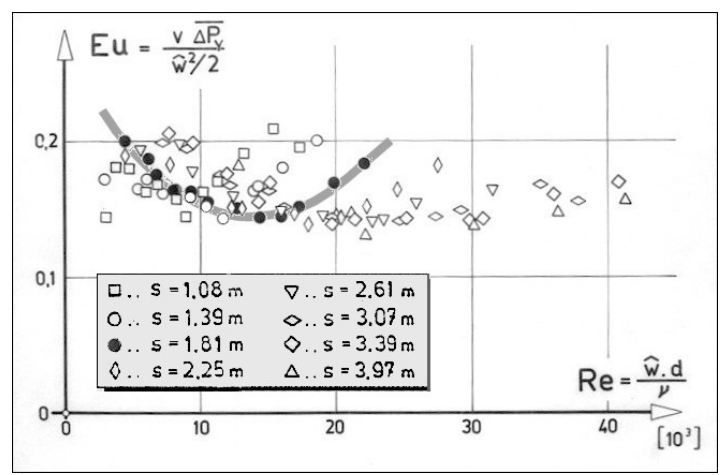
Figure 10. Euler number Eu of the measured pressure in the settling vessel plotted as a function the nozzle exit flow Reynolds number Re.